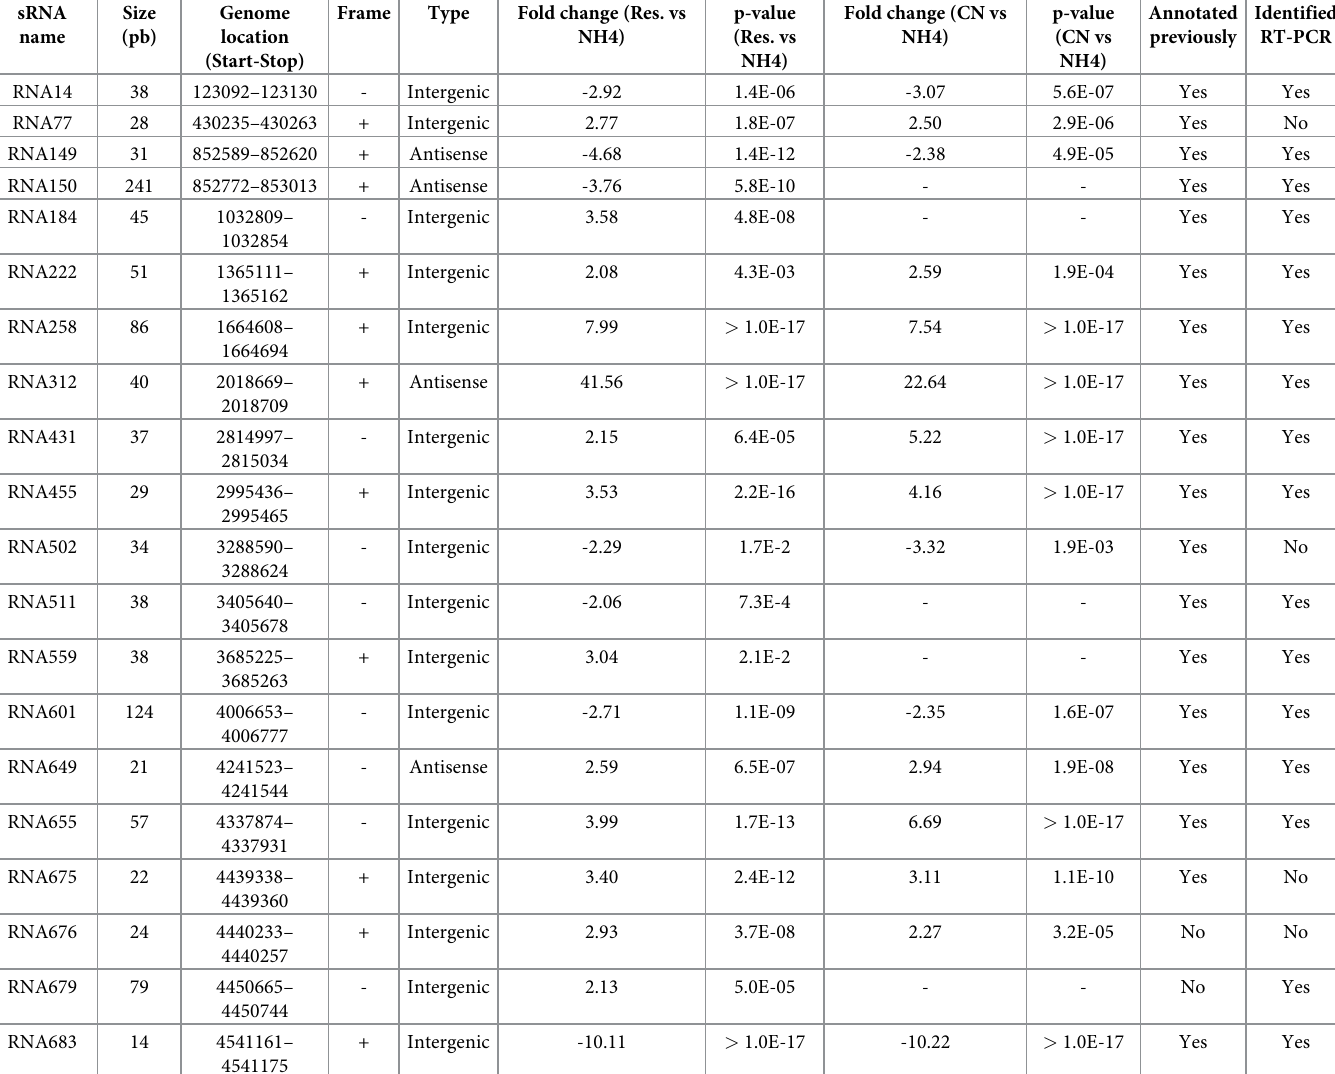
Table 1. Identification and characteristics of putative sRNAs involved in the detoxification of cyanide-containing